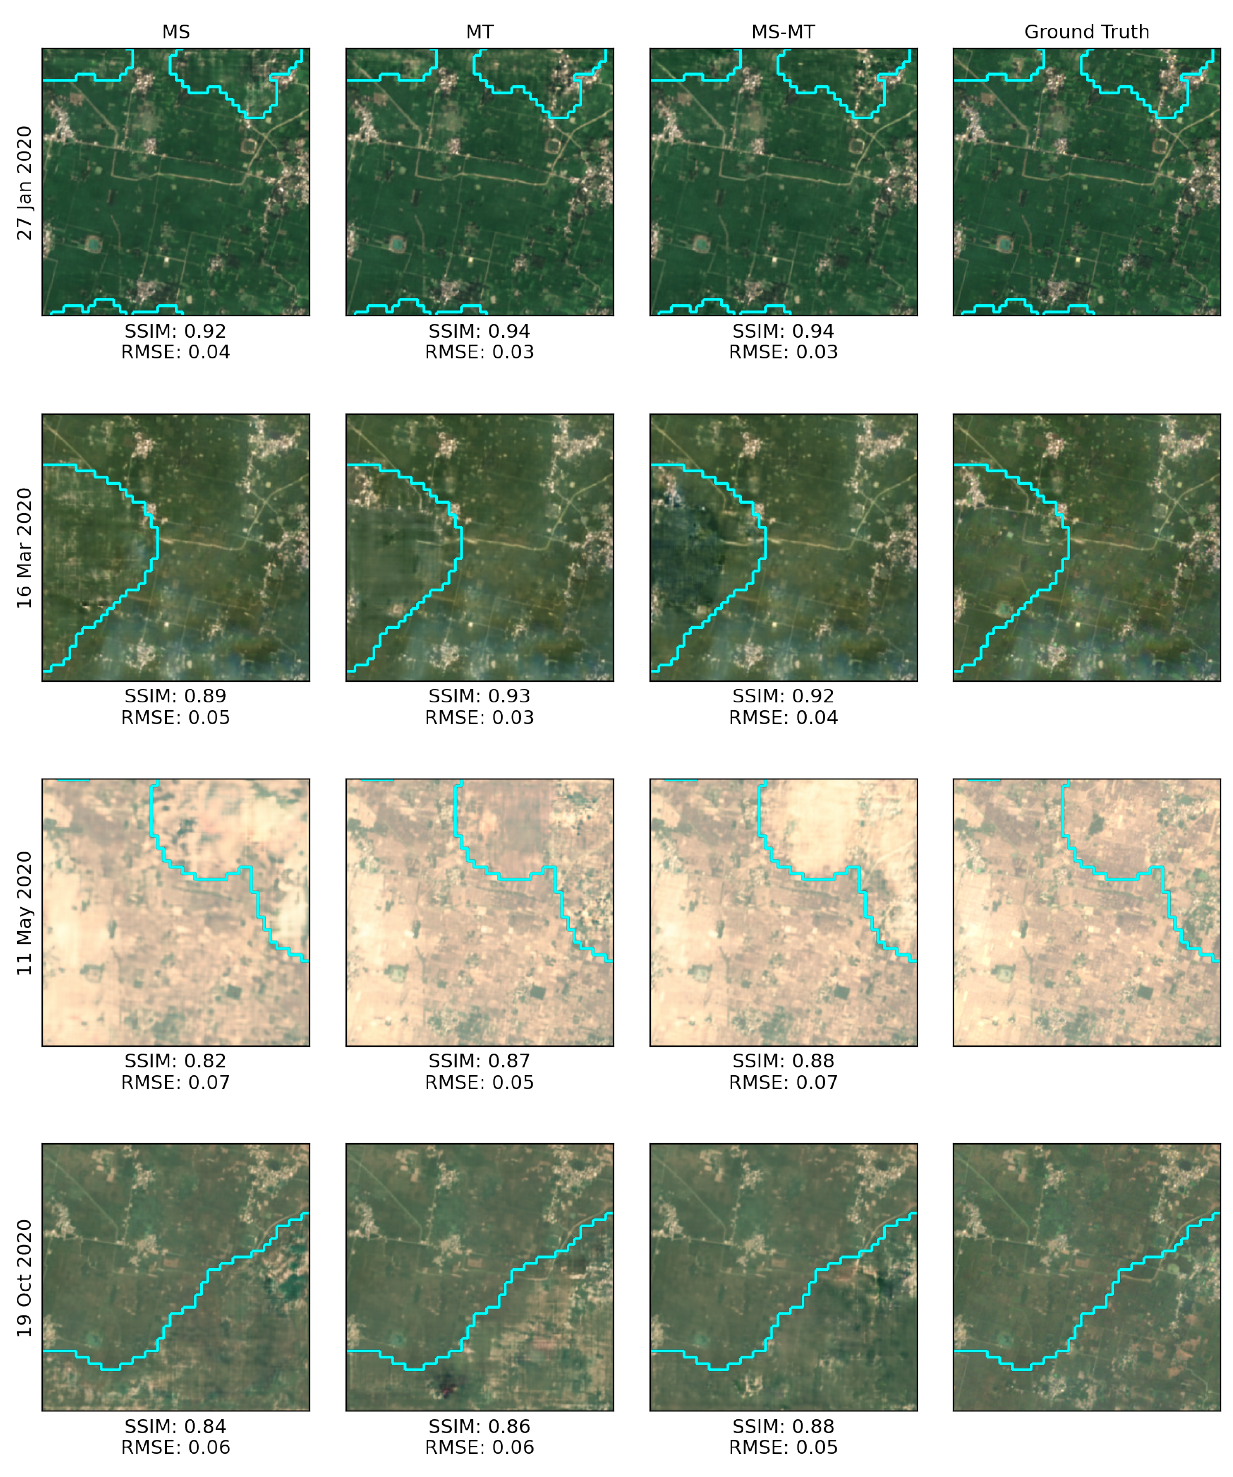
Figure 8. A selection of reconstructed samples across the full year in the India region. This demon- strates the seasonal adaptability of the proposed methods. The cyan line delineates the cloud-affected from the cloud-free regions in the